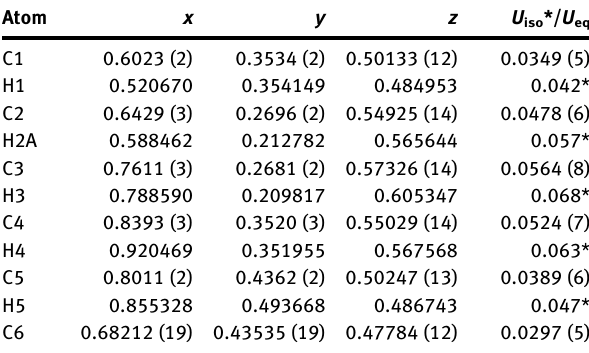
Table  : Fractional atomic coordinates and isotropic or equivalent isotropic displacement parameters (Å 